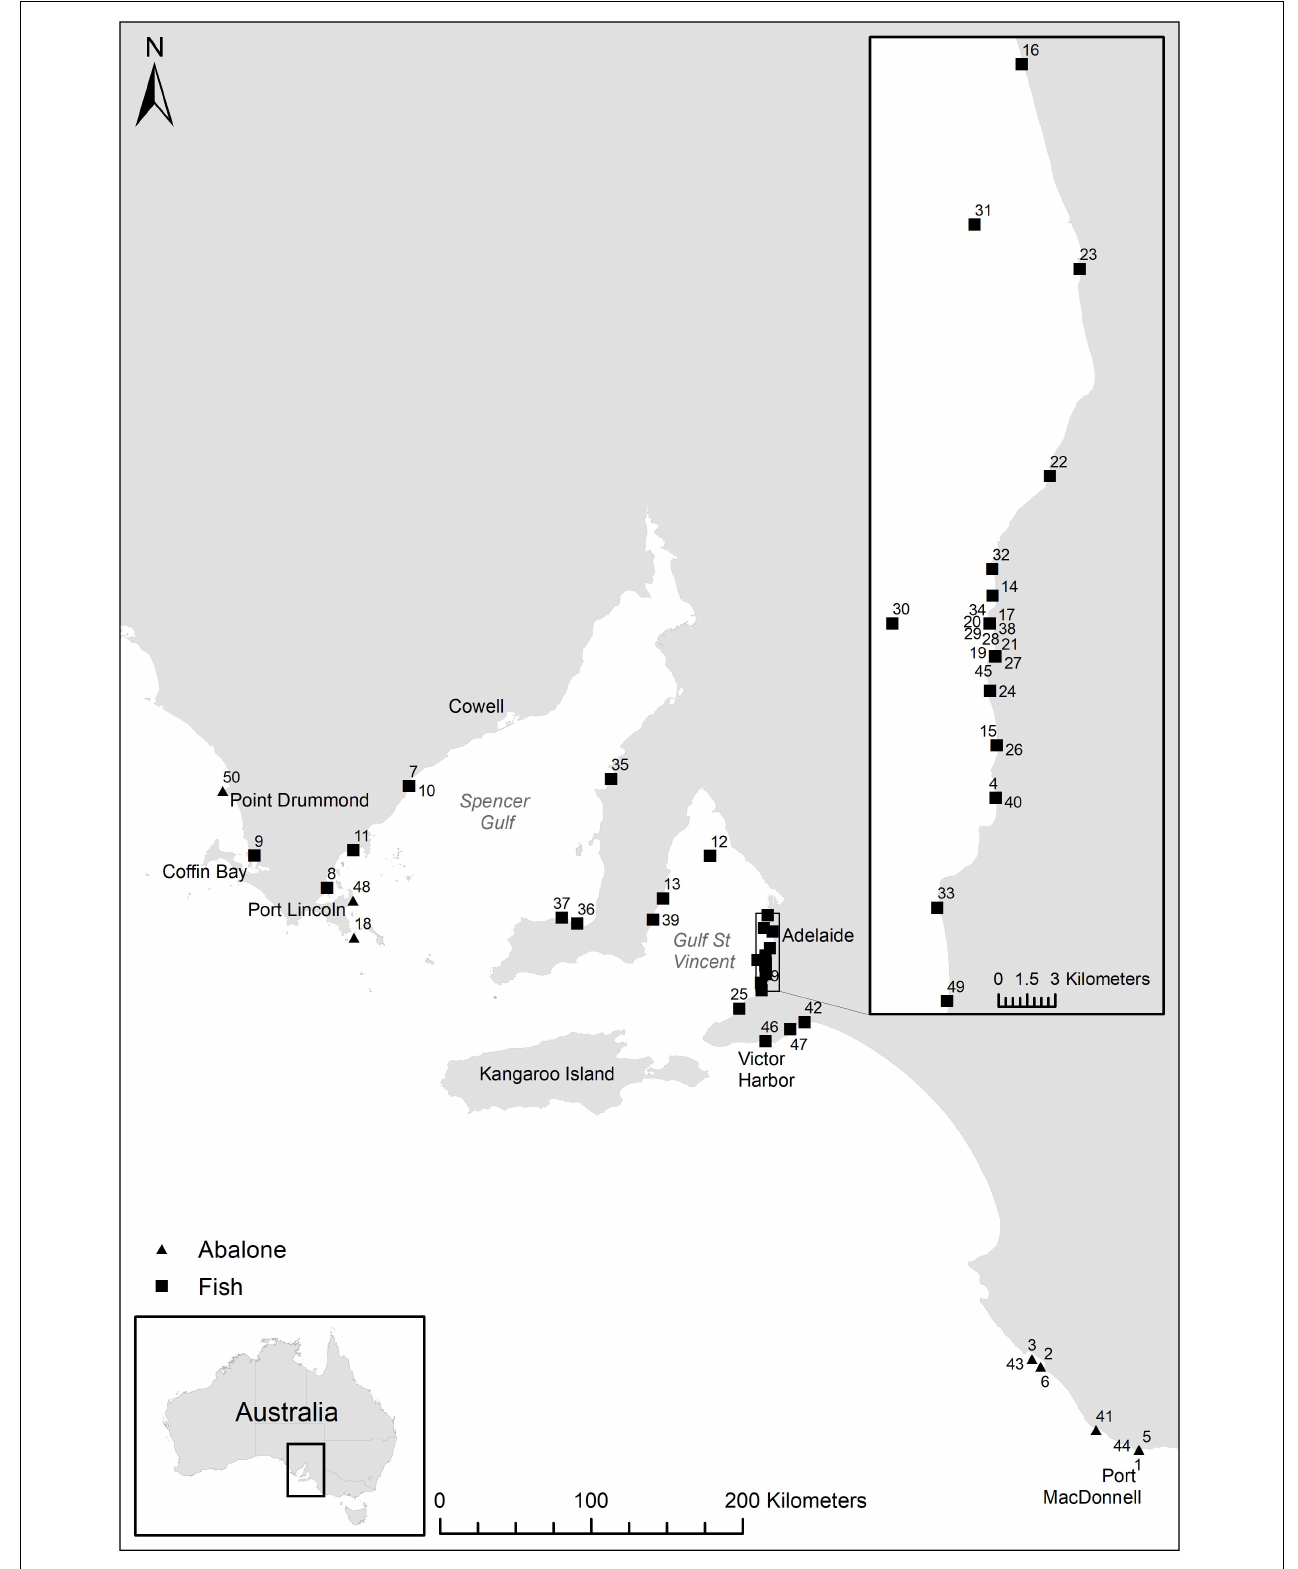
FIGURE 1 | Reported fish kill (fish and abalone) locations across South Australia. Numbers refer to fish kill events in Table 1 .